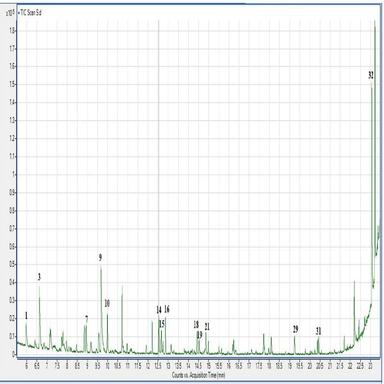
GC–MS chromatogram of bio-oil of the raw material.